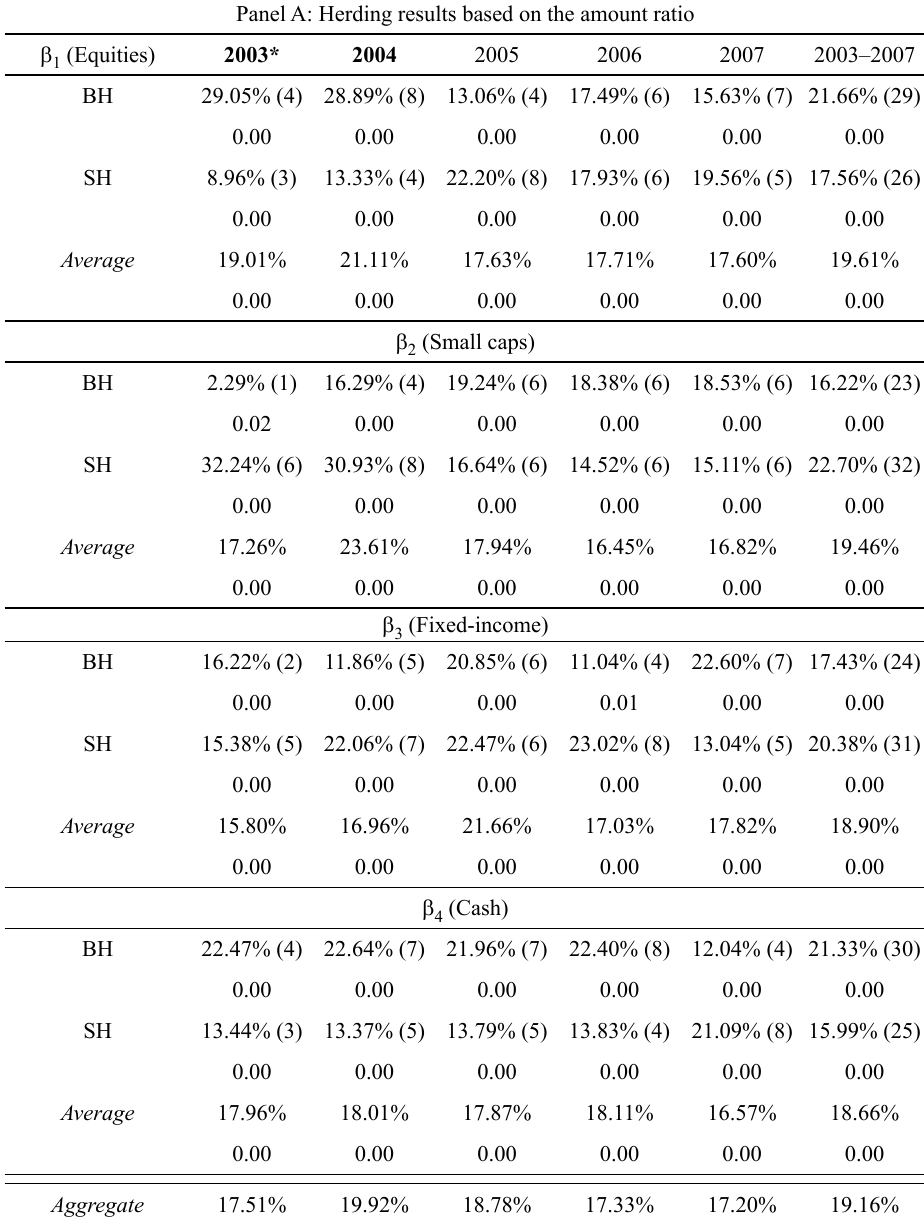
Table 6. Herding results based on the amount ratio Panel A: Herding results based on the amount